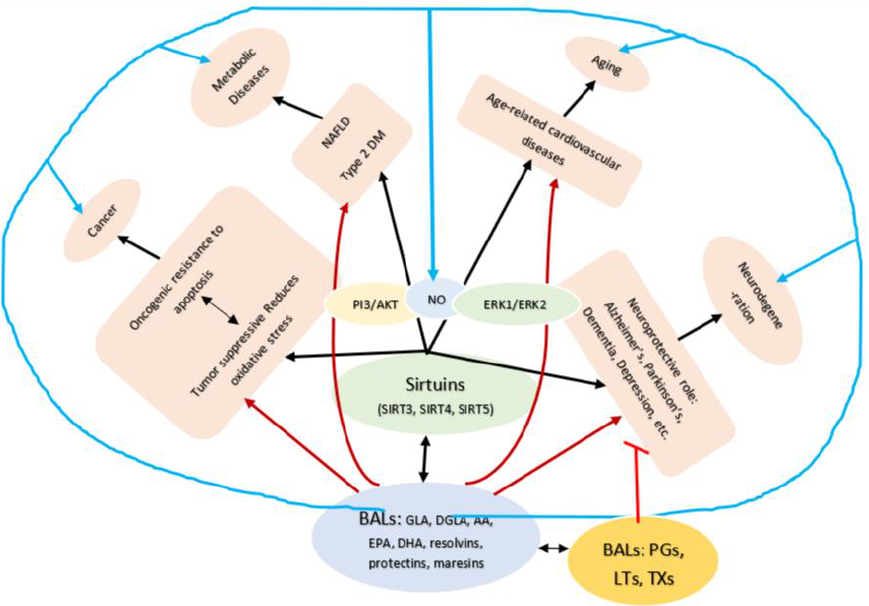
Figure 7. Scheme showing potential relationship between SITs (sirtuins) and BALs and their role in various age-related diseases. For details see text. various age-related diseases. For details see